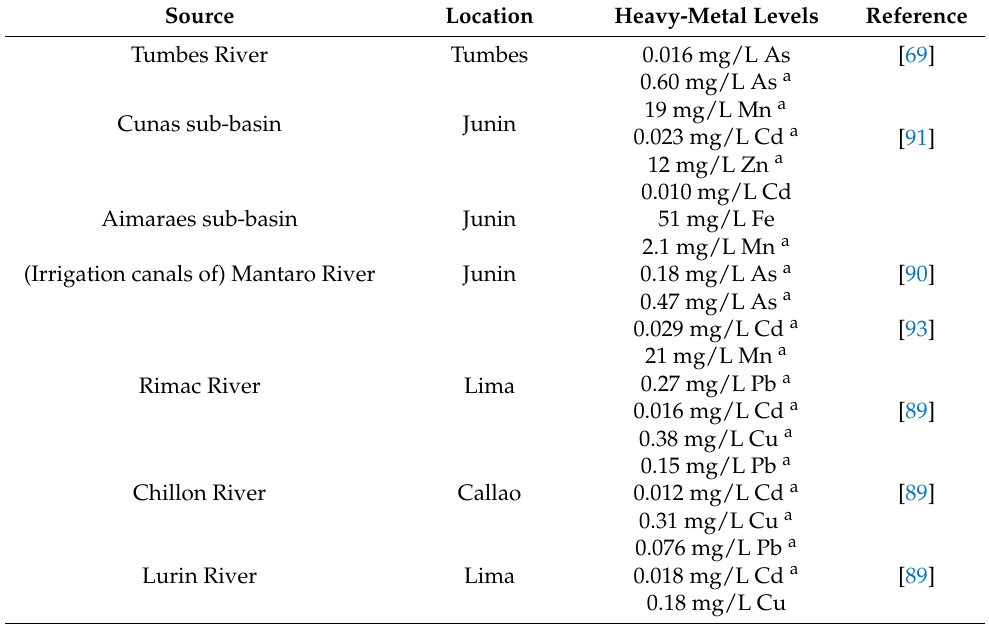
Table 6. Irrigation water contaminated with heavy metals in Peru. Values shown are mean or